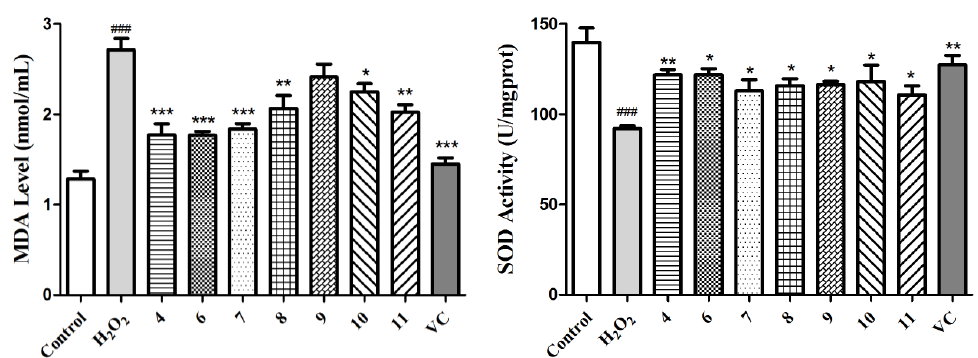
Figure 5. Quantitation of ROS production with compounds 4 and 6 – 11 and the positive control (VC) at 5 µ M in the H 2 O 2 -induced L02 cell injury model. The data of the cells treated with compounds only were similar to those of the control group. Data are expressed as means ± SD ( n = 3). ### p < 0.001 compared to the control group and *** p < 0.001 compared to the model group.